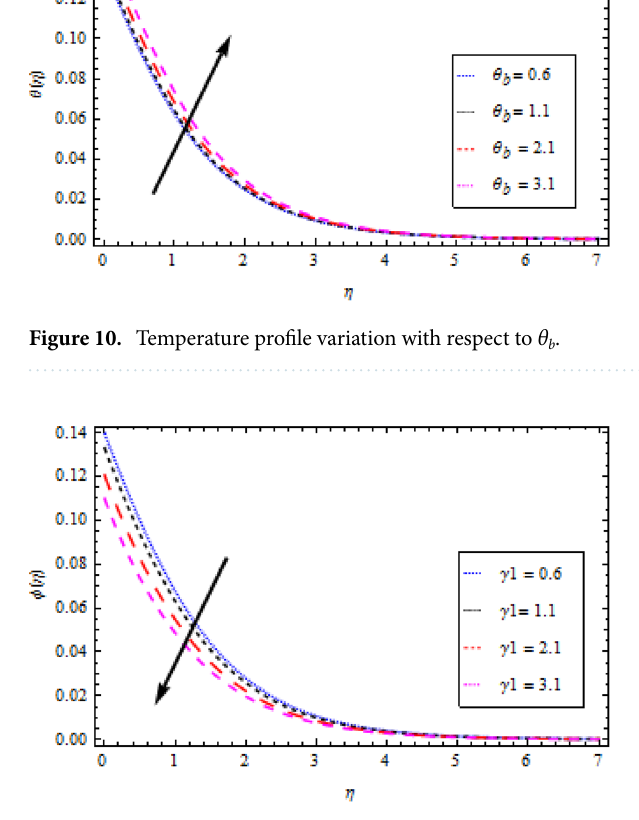
Figure 11. Concentration profile variation with to γ 1 .